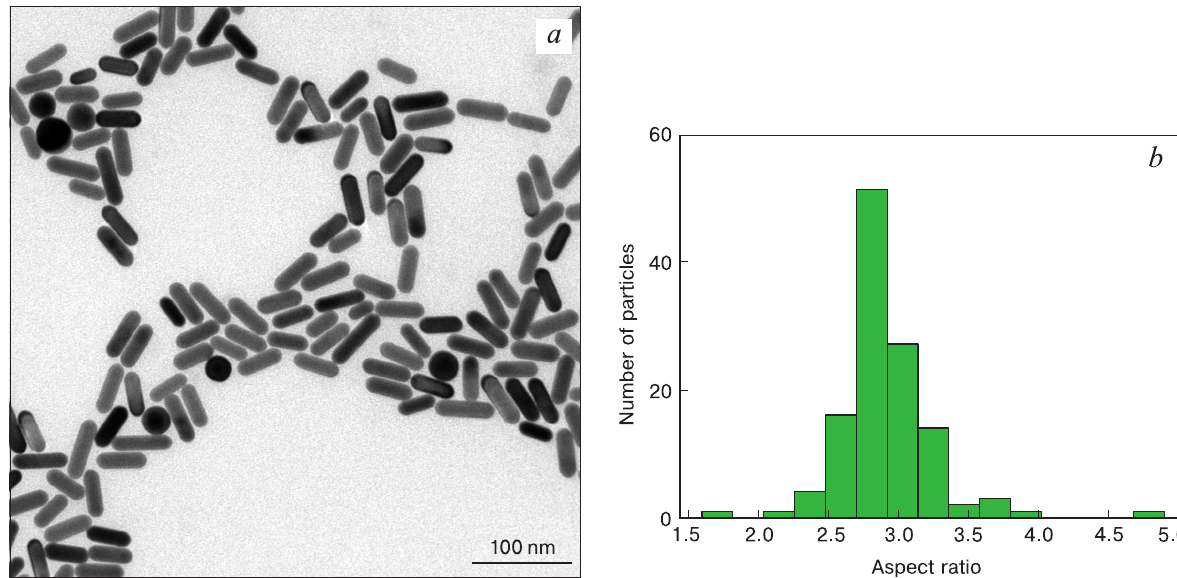
Figure 1. ( a ) Fragment of TEM micrograph for Sample No. 3 and ( b ) particle distribution in sample by aspect ratio obtained from analysis of the